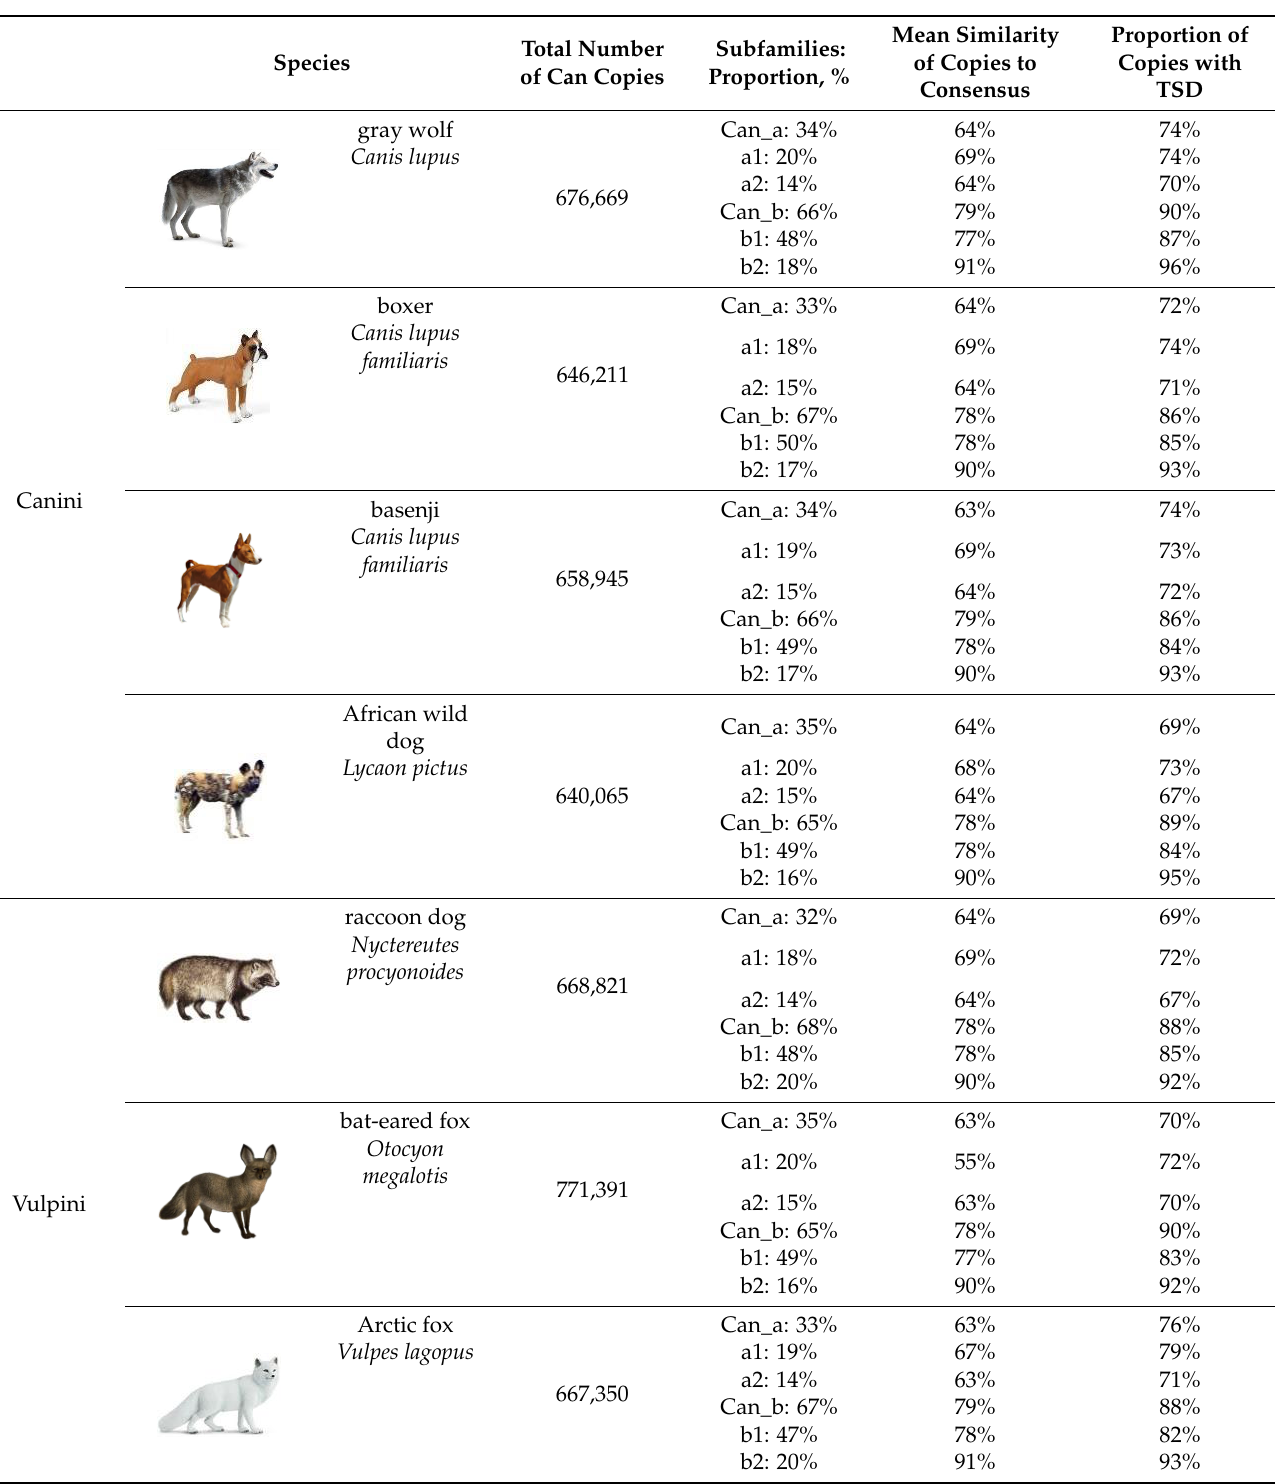
Table 1. Can subfamilies in certain dog-like and fox-like canids.